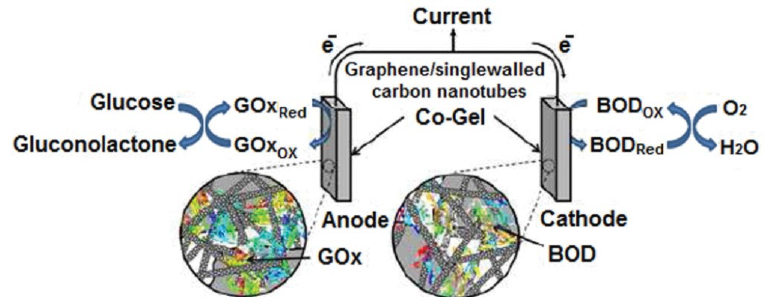
Fig. 10. Schematic representation of the membrane/mediator-free enzymatic glucose biofuel cell utilizing free standing co-gels of graphene/single-walled carbon nanotube as electrodes